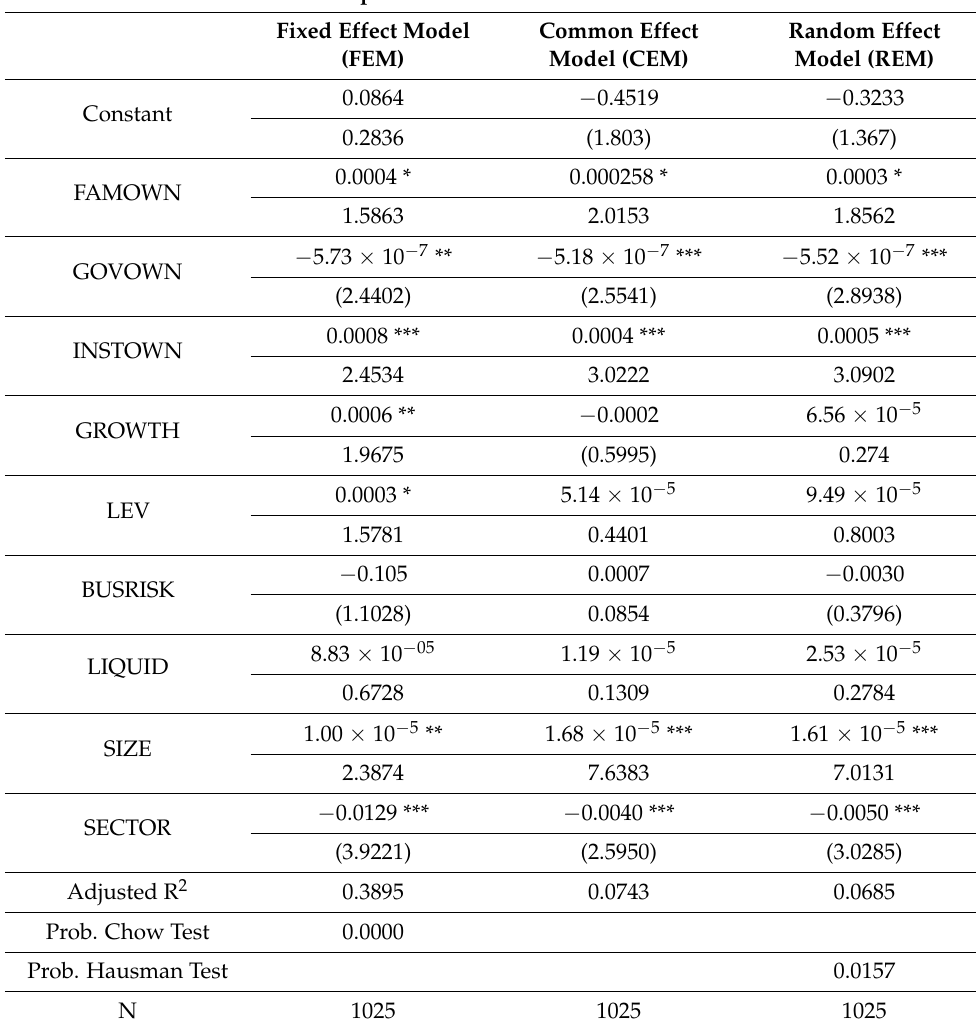
Table 4. Data panel